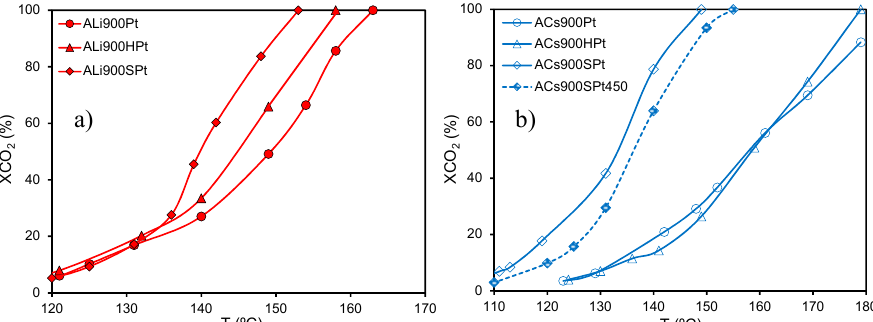
Figure 13. Light-off curves obtained in the benzene combustion for Pt catalysts supported on ( a ) mesoporous and ( b ) macroporous carbon aerogels ([benzene] = 1000 ppm, Q = 3.6 L h − 1 , 0.10 g catalyst ). Figures adapted with permission from [61]. Copyright 2010,